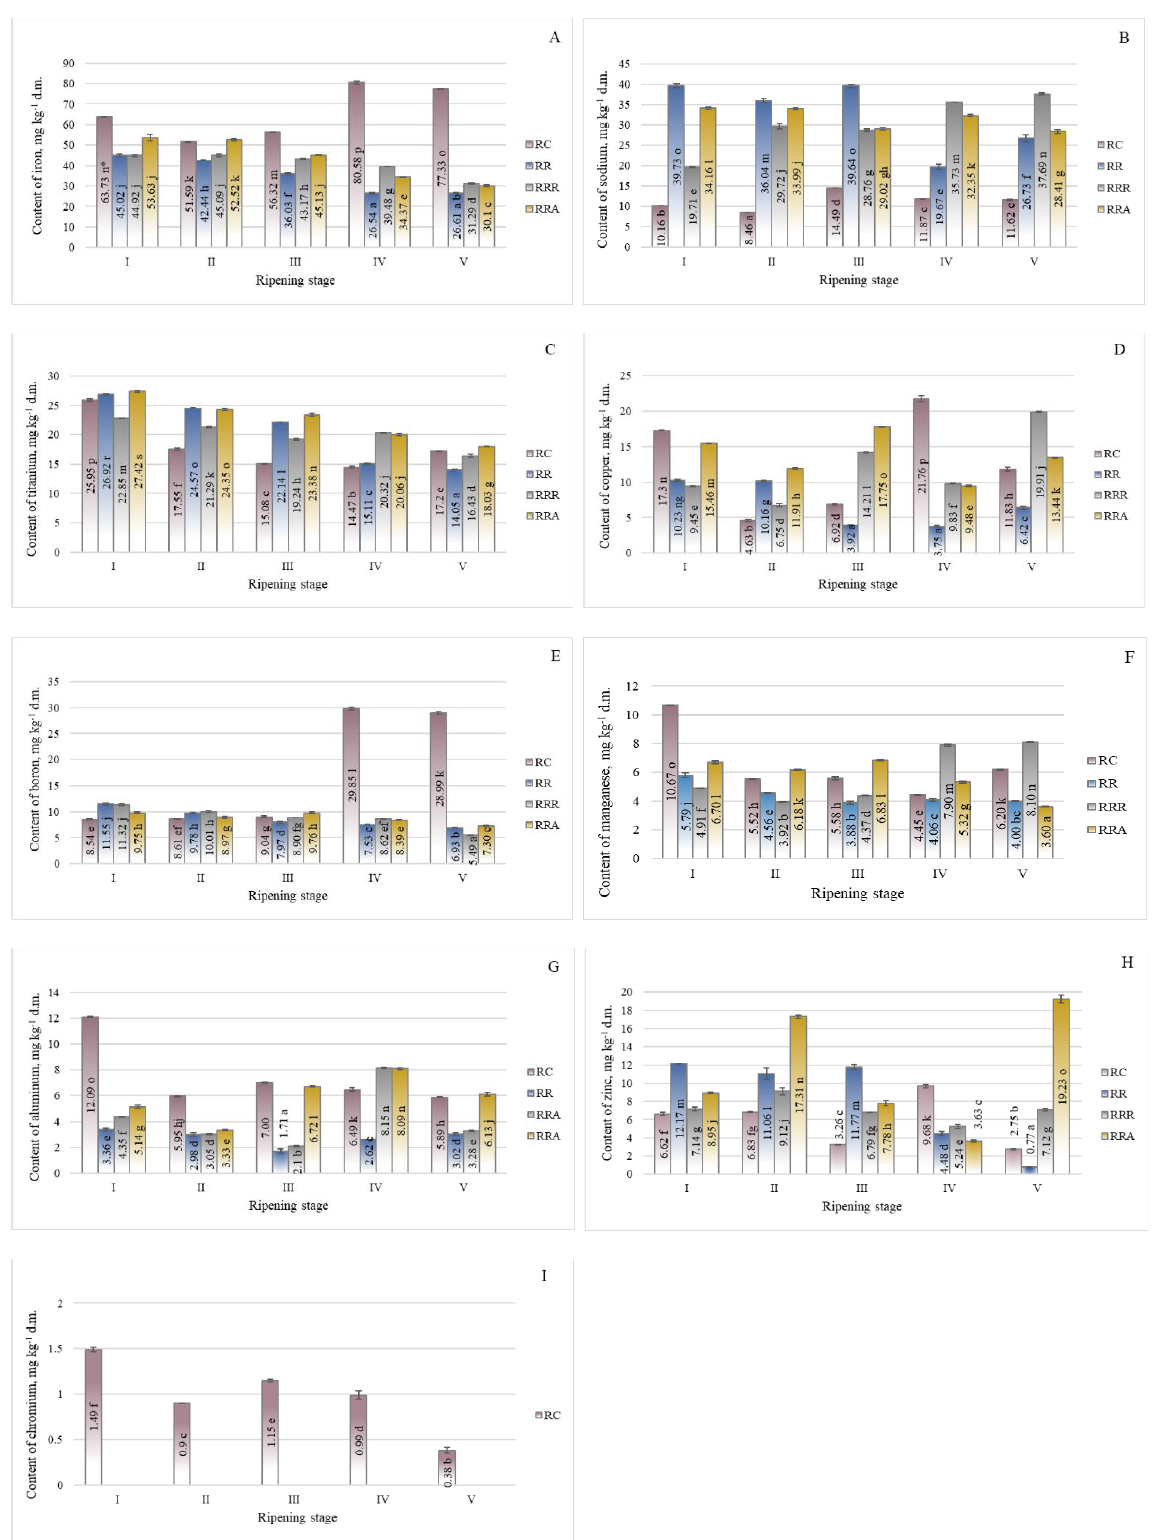
Figure 3. The effect of ripening stages on the content of micro elements (mg kg − 1 d.m.) ( A